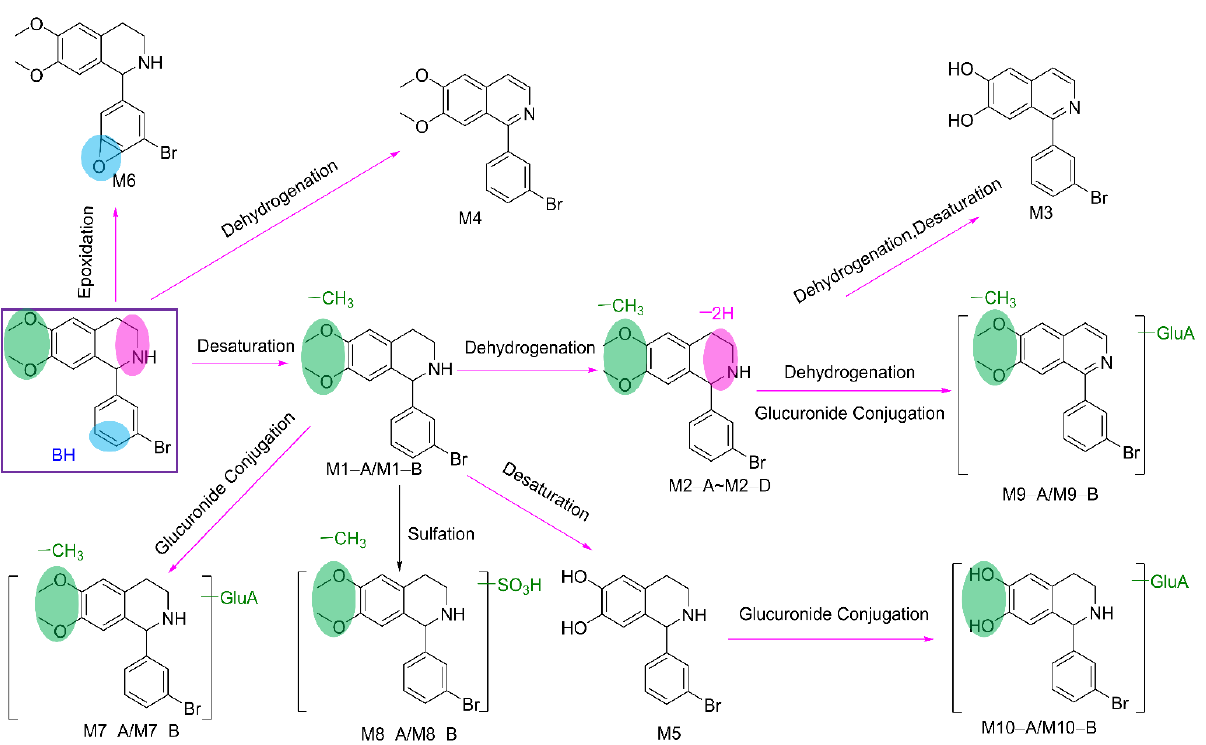
Figure 6. The proposed metabolic pathways of 1 −(3′− bromophenyl) − heliamine.